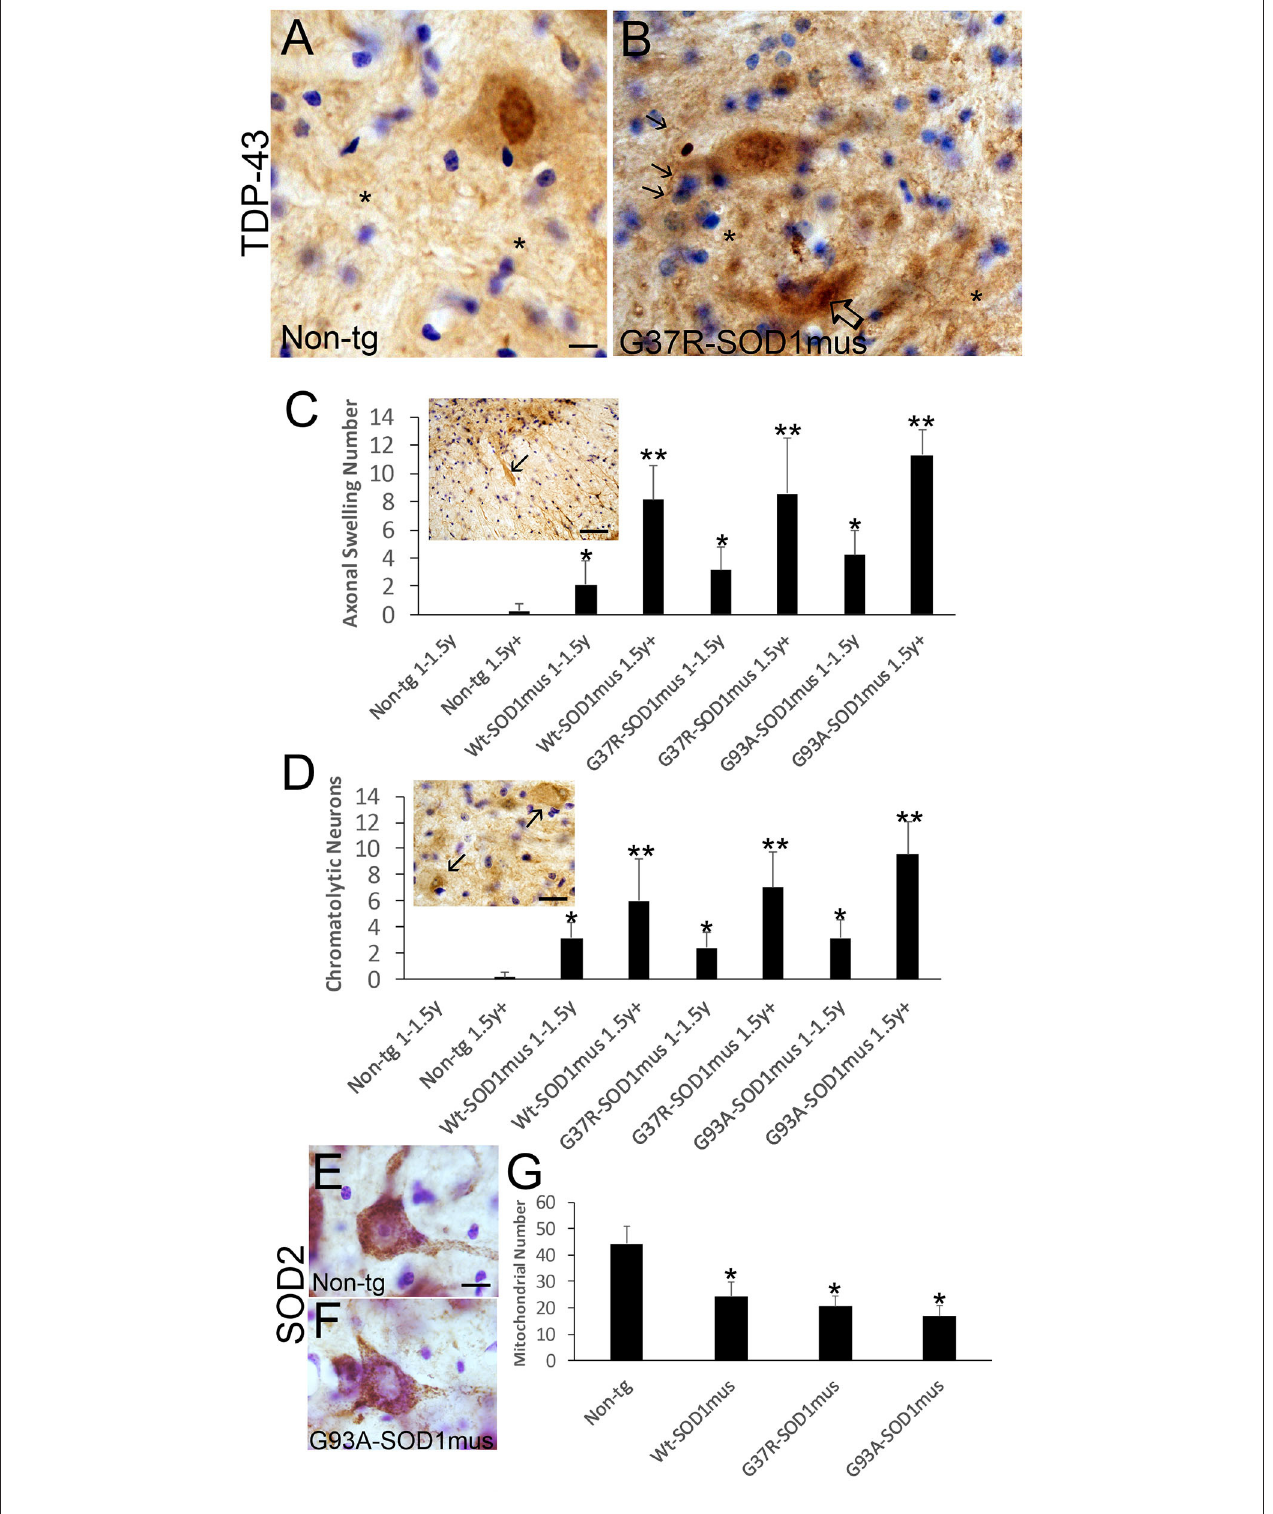
FIGURE 10 | Motor neurons in hSOD1 mus mice develop TDP-43 abnormalities, axonopathy, and mitochondrial depletion. (A,B) TDP-43 immunostaining of motor neurons in non-tg (A) and hSOD1 mus (B) mice. At about midlife (12 months), in normal motor neurons (A) , TDP-43 is highly enriched in the nucleus compared to